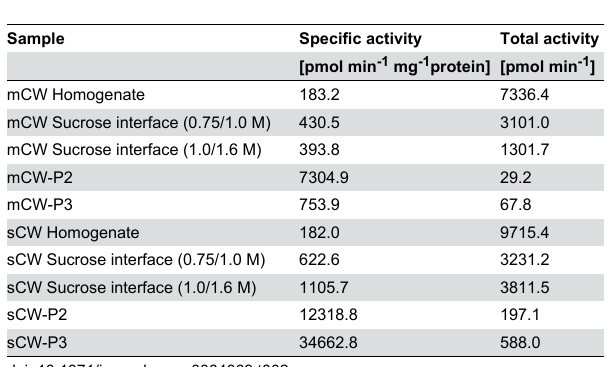
Table 3. Summary of search results after LC-MS/MS analysis of post-FFE fractions mCW-P2, mCW-P3, sCW-P2 and sCW-P3 using the Mascot search